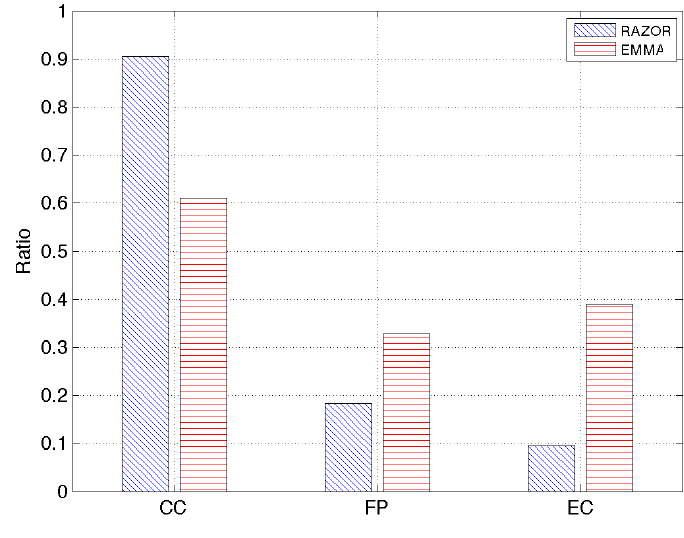
Figure 7. Classification accuracy comparison between RAZOR and Motifs through Matrix Approximation (EMMA): the CC, FP and EC bars report the correct classification, the false positive and erroneous classification